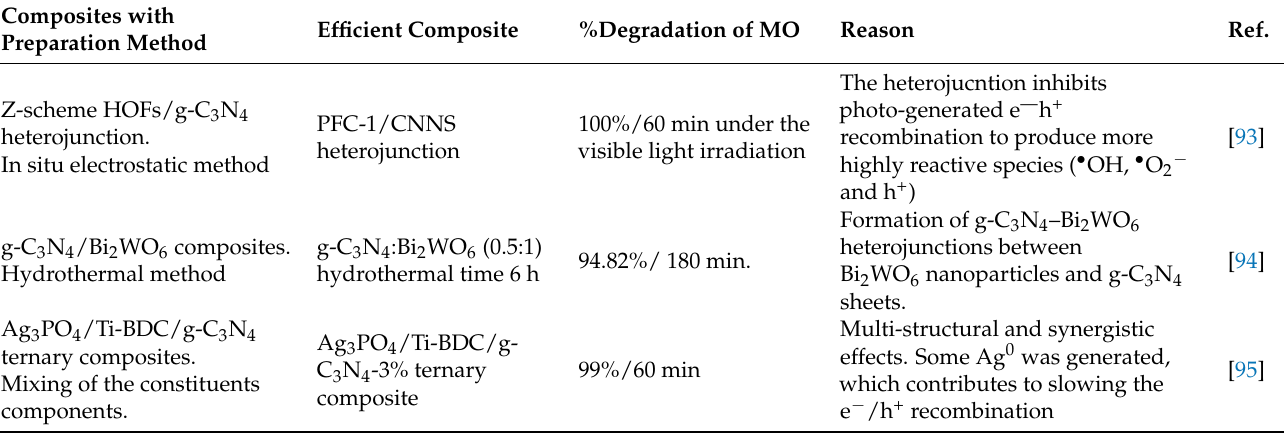
Table 1. g-C 3 N 4 based composites/nanocomposites used for the PD of